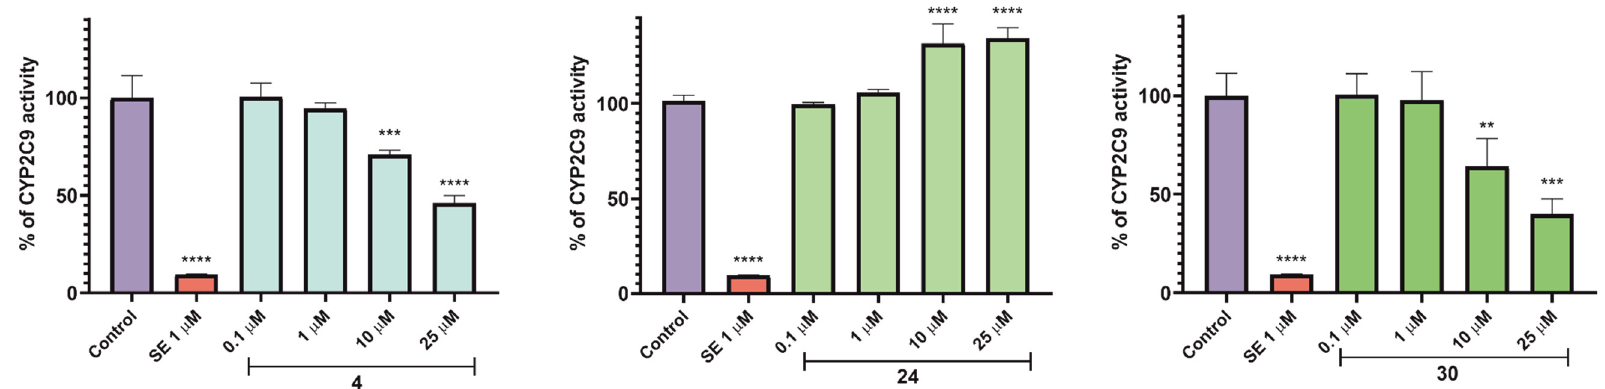
Figure 7. The influence of 4 , 24 , 30 (10 µM) and the reference inhibitor sulfaphenazole (SE) on CYP2C9 activity. Statistical significance (** p < 0.01, *** p < 0.001, **** p < 0.0001) was analyzed by Graph Pad Prism 8.0.1 software using one-way ANOVA and Bonferroni’s multiple comparison post test. The compounds were examined in triplicate.